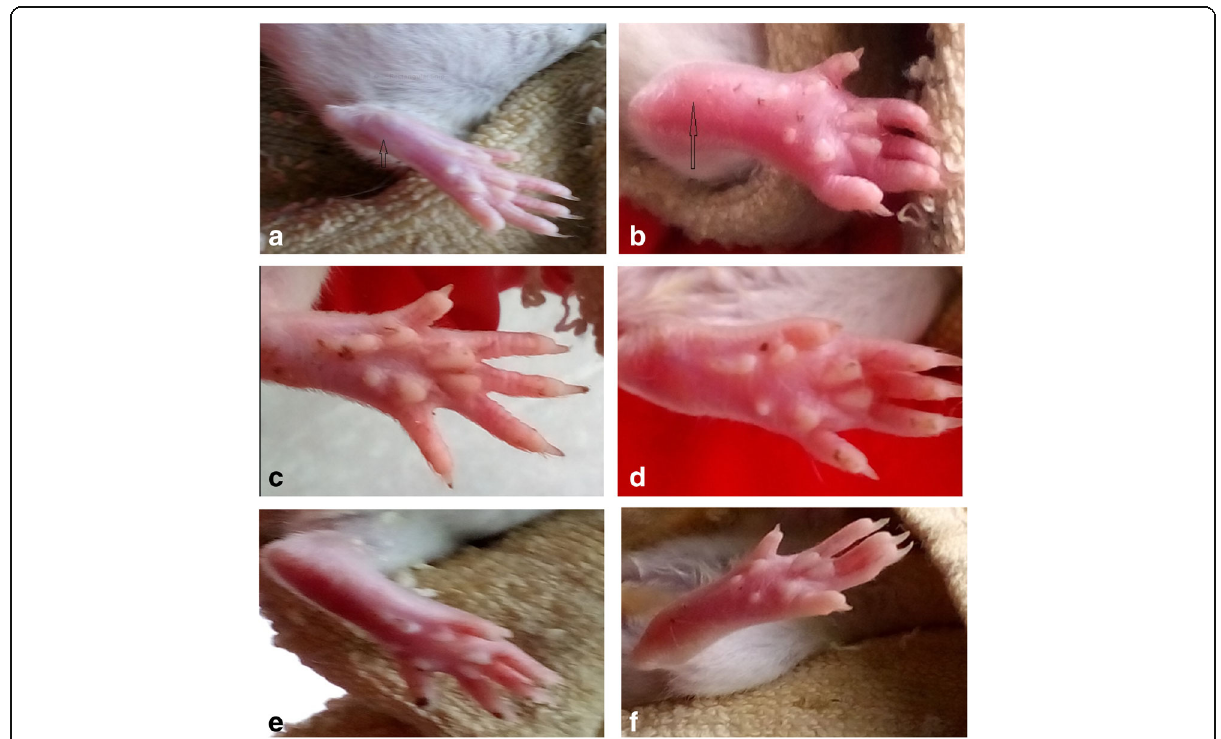
Fig. 1 Effect of methanolic extract of P. niruri on carrageenan induced paw edema after 6 h. a = Normal control: no erythema and inflammation were observed. b Carrageenan control: severe erythema and swelling were observed. c 20 mg/kg ibuprofen: mild amount of erythema and swelling were observed. d 100 mg/kg methanolic extract of P. niruri : moderate amount of erythema and swelling were observed e 200 mg/kg methanolic extract of P. niruri : moderate amount of erythema and swelling were observed. f 400 mg/kg methanolic extract of P. niruri : mild amount of erythema and swelling were observed. The small arrow indicates the absence of swelling and erythema whereas the large arrow indicates severe swelling and erythema in the rats